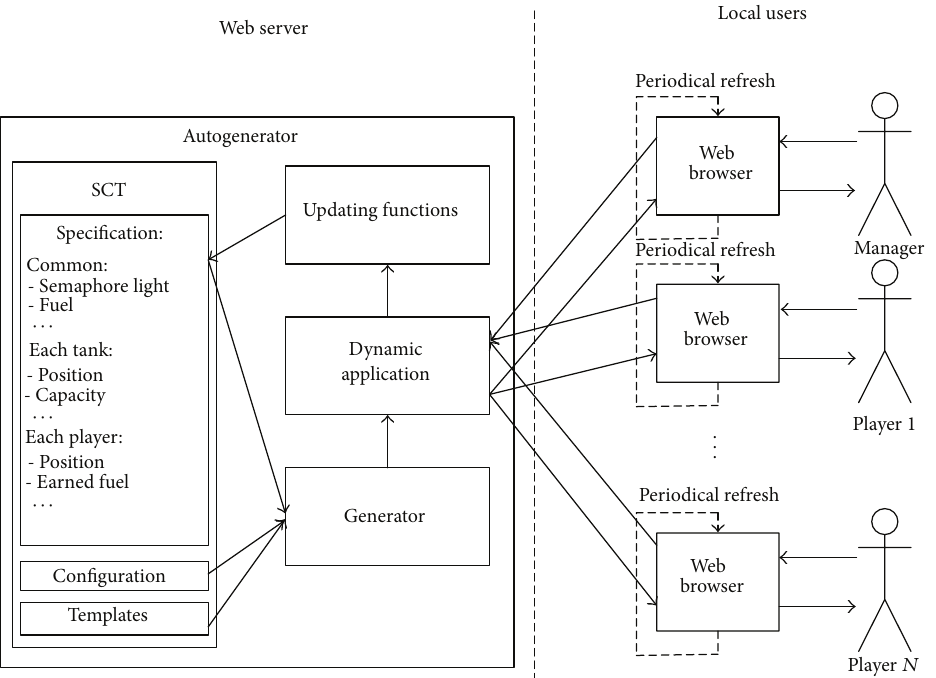
Figure 4: Extended autogenerator model in a strategic game example.